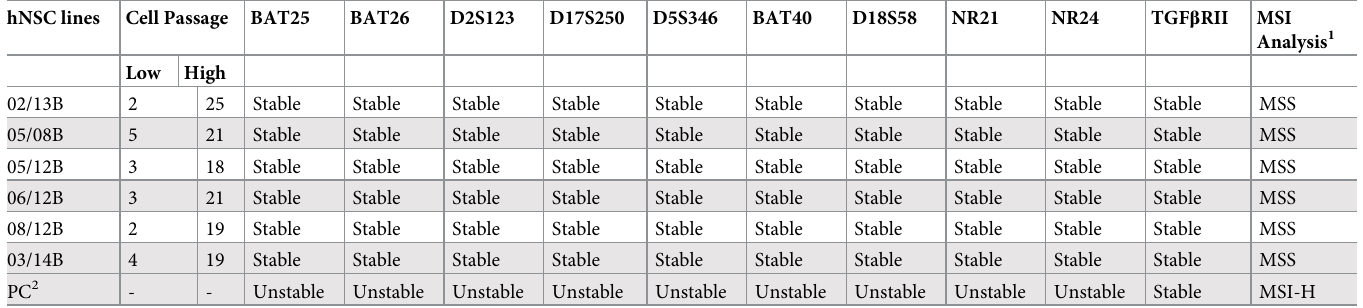
Table 2. Results for the hNSCs